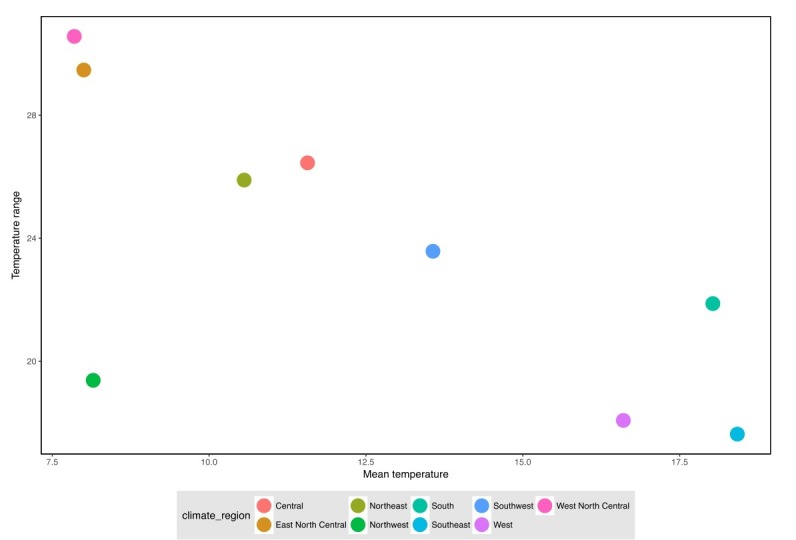
The relationship between annual mean temperature (used in European papers) and temperature range between maximum and minimum mortality months (used in our paper).